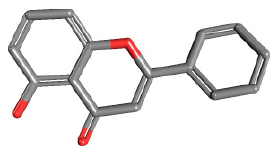
Figure 1. Primuletin (5-hydroxyflavone).